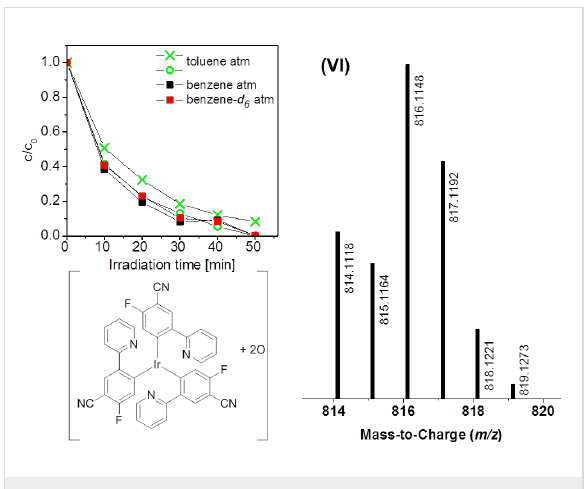
Figure 9: Degradation curves of Ir(F,CN-ppy) 3 in benzene, benzene- d 6 and toluene under ambient conditions and mass spectrum of the detected degradation product, which matches a twofold-oxidized derivative with regard to its m / z value and the corresponding isotope